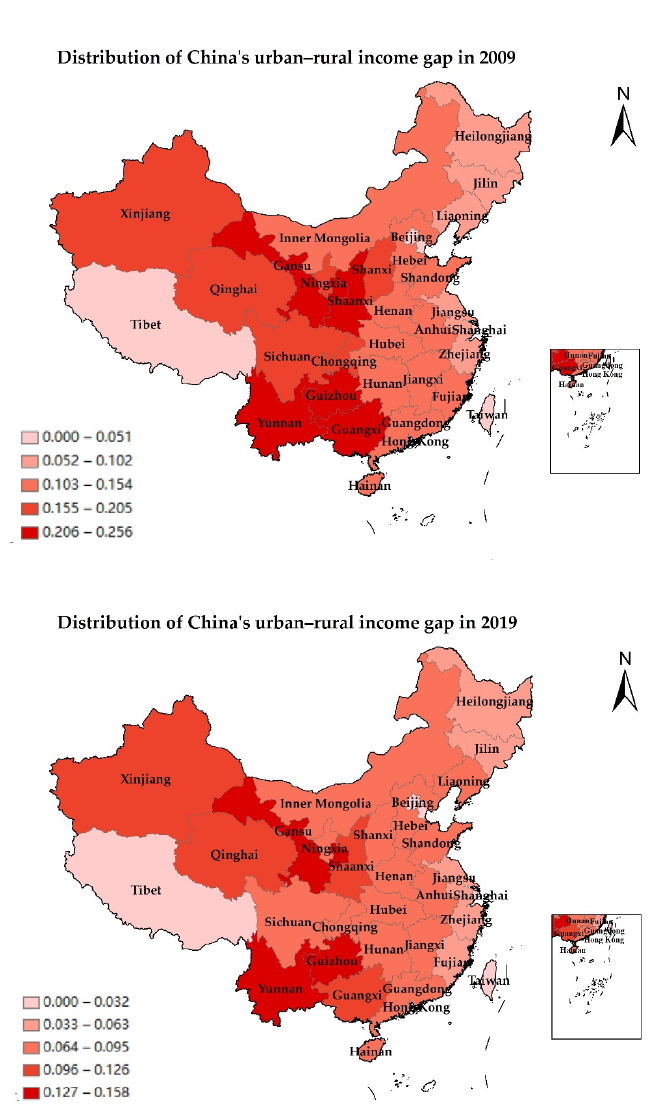
Figure 4. Composite Index of Urban–Rural Income Gap between Provinces in China for 2009 and 2019.